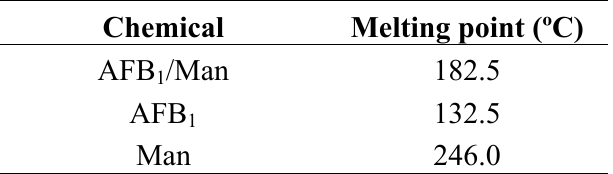
Table 2. Melting points of the crystals formed by aflatoxin B (Man), and of the independent